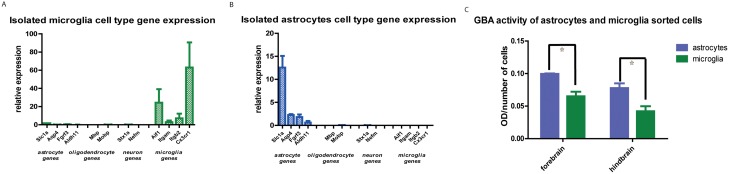
GBA in sorted CD11b positive microglia and GLT1 positive astrocyte populations.(A) RT PCR mRNA expression of CD11b positive sorted cells. (B) RT PCR mRNA expression of GLT1 positive sorted cells. (C). Quantification of green MDW933-labeled GBA in microglia and astrocytes expressed per number of cells.